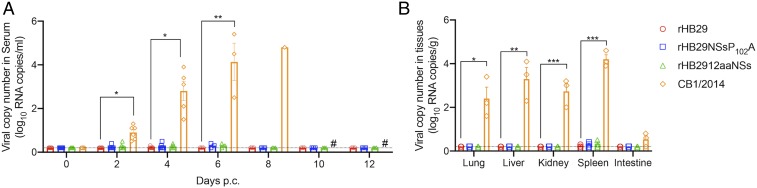
Distribution of viral RNA copies in blood and tissues of challenged ferrets. Six ferrets in each group were i.m. inoculated with 107.6 TCID50 of CB1/2014. At the time points indicated following lethal challenge, serum viral RNA copy numbers were determined by real-time PCR (A). At 5 d p.i., 3 ferrets in each group were killed, and tissues (lung, liver, kidney, spleen, and intestine) were assessed for viral RNA copy number by real-time PCR (B). The one-way ANOVA with Dunnett multiple comparison test was used to assess P values compared with each day p.i. of rHB29. *P < 0.0001 and **P = 0.0005 (A); *P = 0.001, **P = 0.0001, and ***P < 0.0001 (B). # No samples were collected as animals had died/been killed.